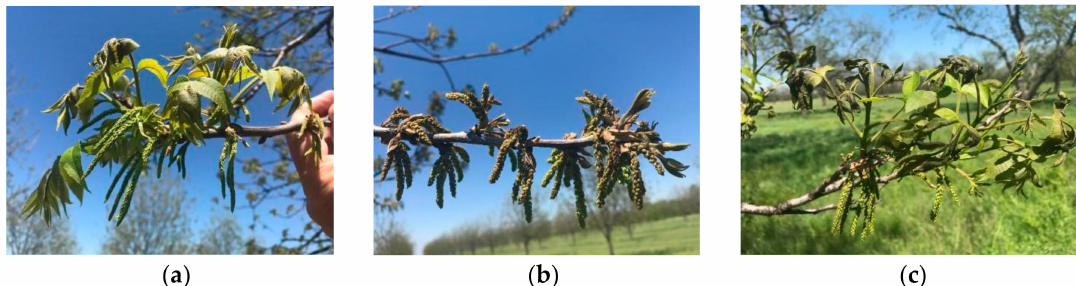
Figure 3. Variation in freeze damage (15 April 2020) among cultivars: ( a ) Leaf damage on ‘Kanza’ pecan. ( b ) ‘Oconee’ su ff ered leaf catkins and terminal bud damage. ( c ) Improved varieties such